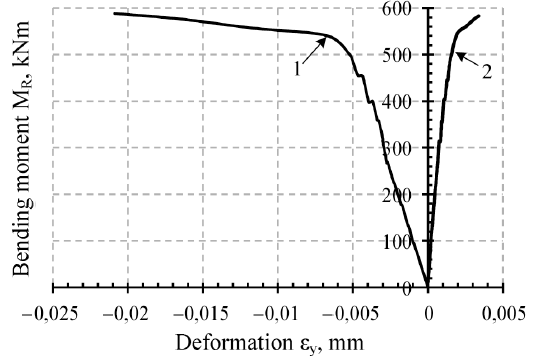
Fig. 6. The average longitudinal bending moment-strain depen- dence of the slab PL-1: 1 – in the tensile zone of the slab; 2 – in the compressive zone of the slab